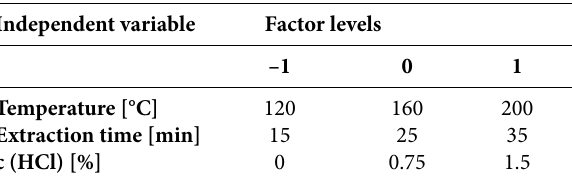
Table 1. Experimental domain with natural and coded values of in- dependent variables used in BBD Independent